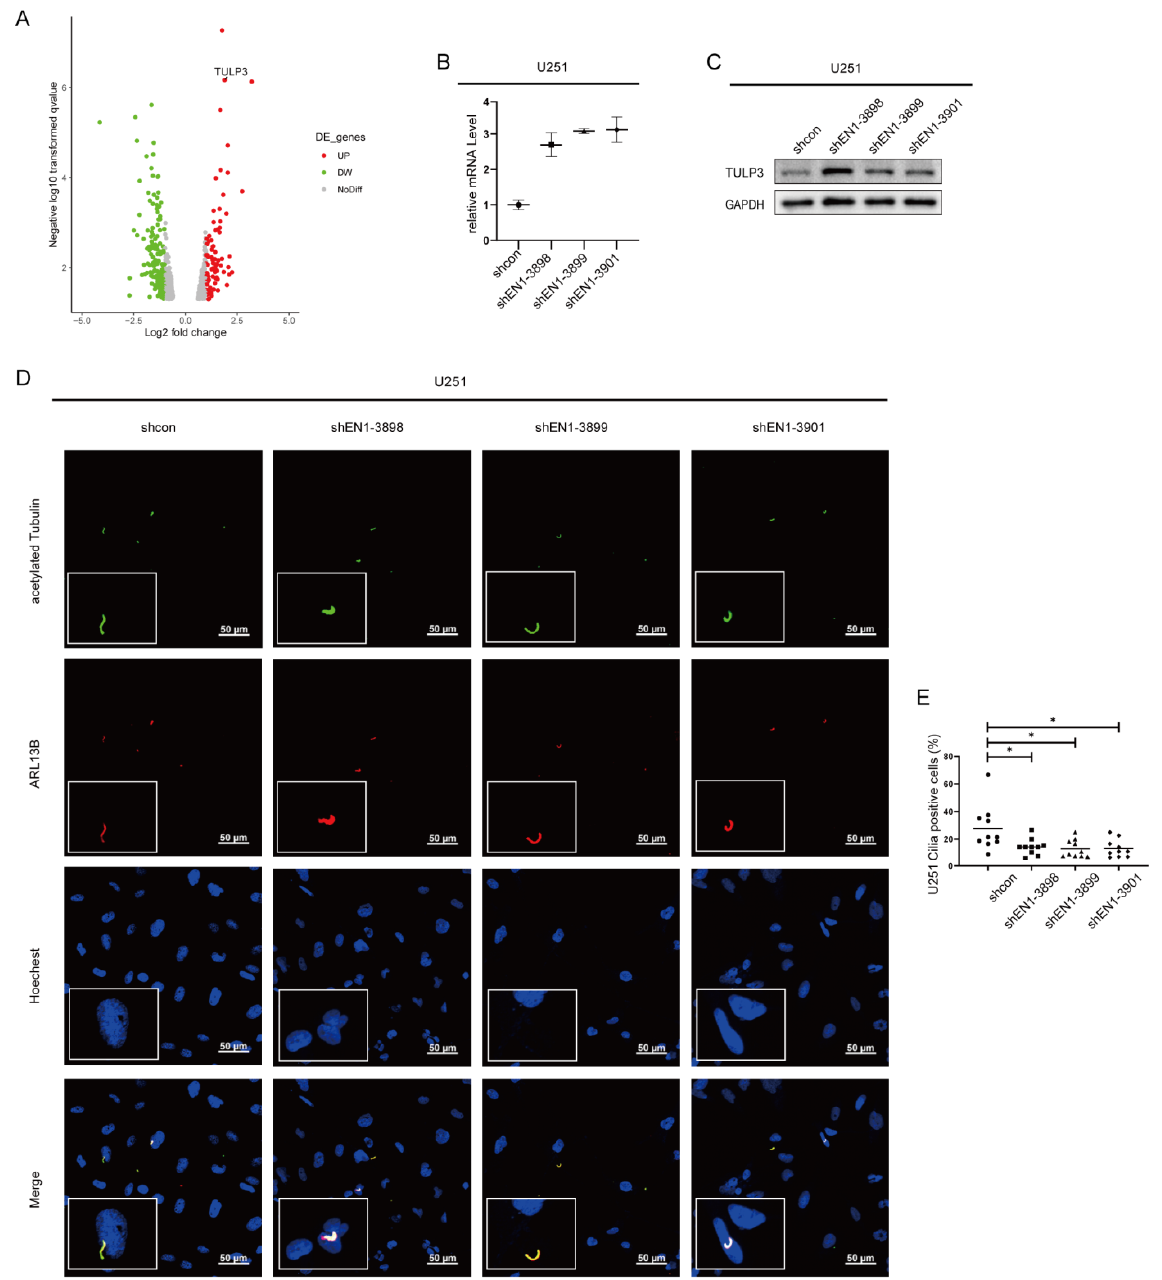
Figure 5. Silencing EN1 upregulates the expression of TULP3. ( A ) Volcano plot of differentially expressed genes (DEGs) in EN1 knockdown glioma cells (vs. scramble control cells). qPCR ( B ) and immunoblotting ( C ) confirmed that EN1 knockdown glioma cells have elevated TULP3. ( D ) Staining of glioma cells with antibodies against ARL13B and acetylated tubulin. ( E ) EN1 knockdown significantly decreased the number of primary cilia. Scale bar: 50 μ m. Data are presented as the mean from three independent experiments ( ● for shcon, ■ for shEN1-3898, ▲ for shEN1-3899, ◆ for shEN1-3901). * p < 0.05 according to Student’s t -test.